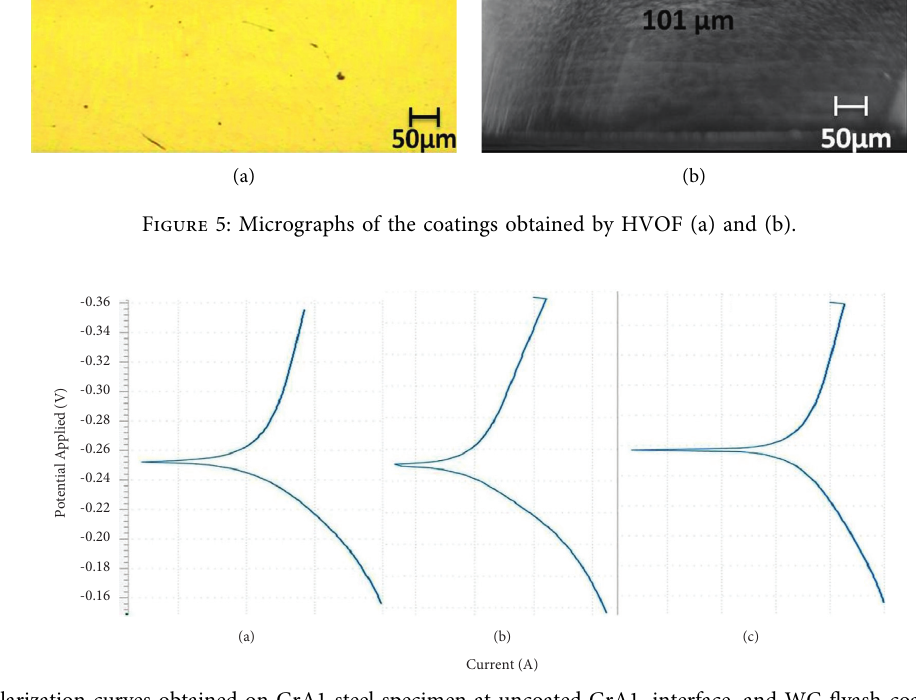
Figure 6: Polarization curves obtained on GrA1 steel specimen at uncoated GrA1, interface, and WC-flyash-coated GrA1